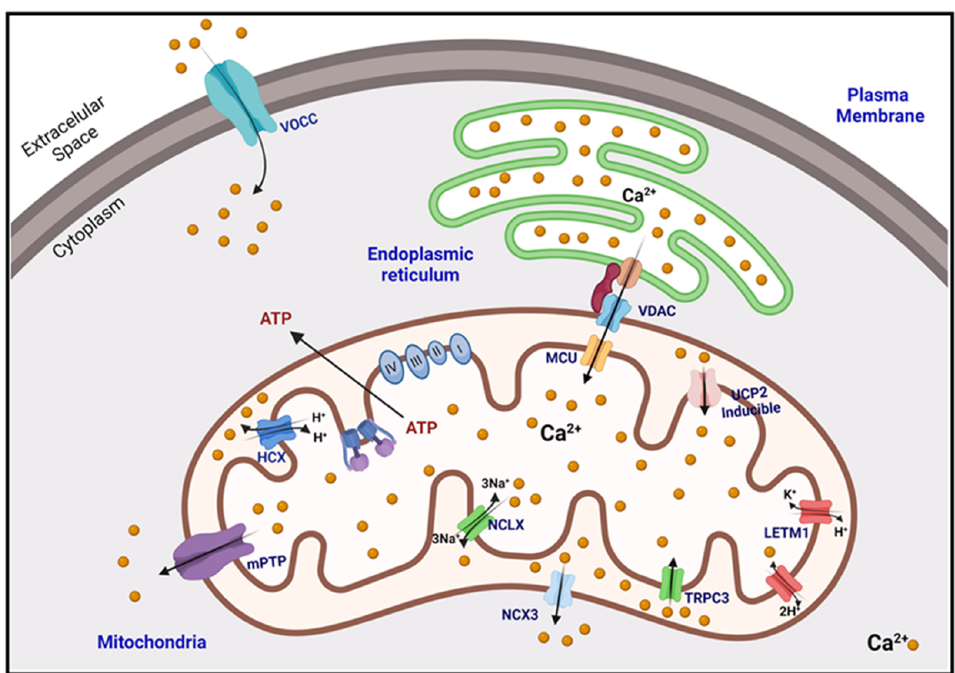
Figure 1. The general model of calcium transport in cells. Anchored in the outer mitochondrial membrane (OMM), are the voltage-dependent transports (VDACs), which mainly uptake calcium from cytosol to the intermembrane space (IMS). However, sometimes exclude calcium as well as the NCX3 transporter and the mitochondrial permeability transition pore (mPTP). In the inner mitochondrial membrane (IMM) calcium is transported to the matrix through some transporters such as the mitochondrial Ca 2+ uniporter complex (MCU), which is a ubiquitous uniporter. The K + /H + or Ca 2+ /H + antiporter leucine zipper containing transmembrane protein 1 (LETM1), the mitochondrial uncoupling protein UPC, and the canonical short transient receptor potential channel 3 (TRPC3). For the exclusion, two primary transporters have been described: the mitochondrial Na + /Ca 2+ exchanger (NCLX) and the mitochondrial H + /Ca 2+ exchanger (HCX). Mitochondria also present contact sites with the ER and PM, forming zones of high calcium concentration, compared with bulk cytoplasmic calcium, so called microdomains. On the other hand, PM presents some voltage-operated calcium channel (VOCC) transporters nearby contact sites with mitochondria, where the microdomains are formed.